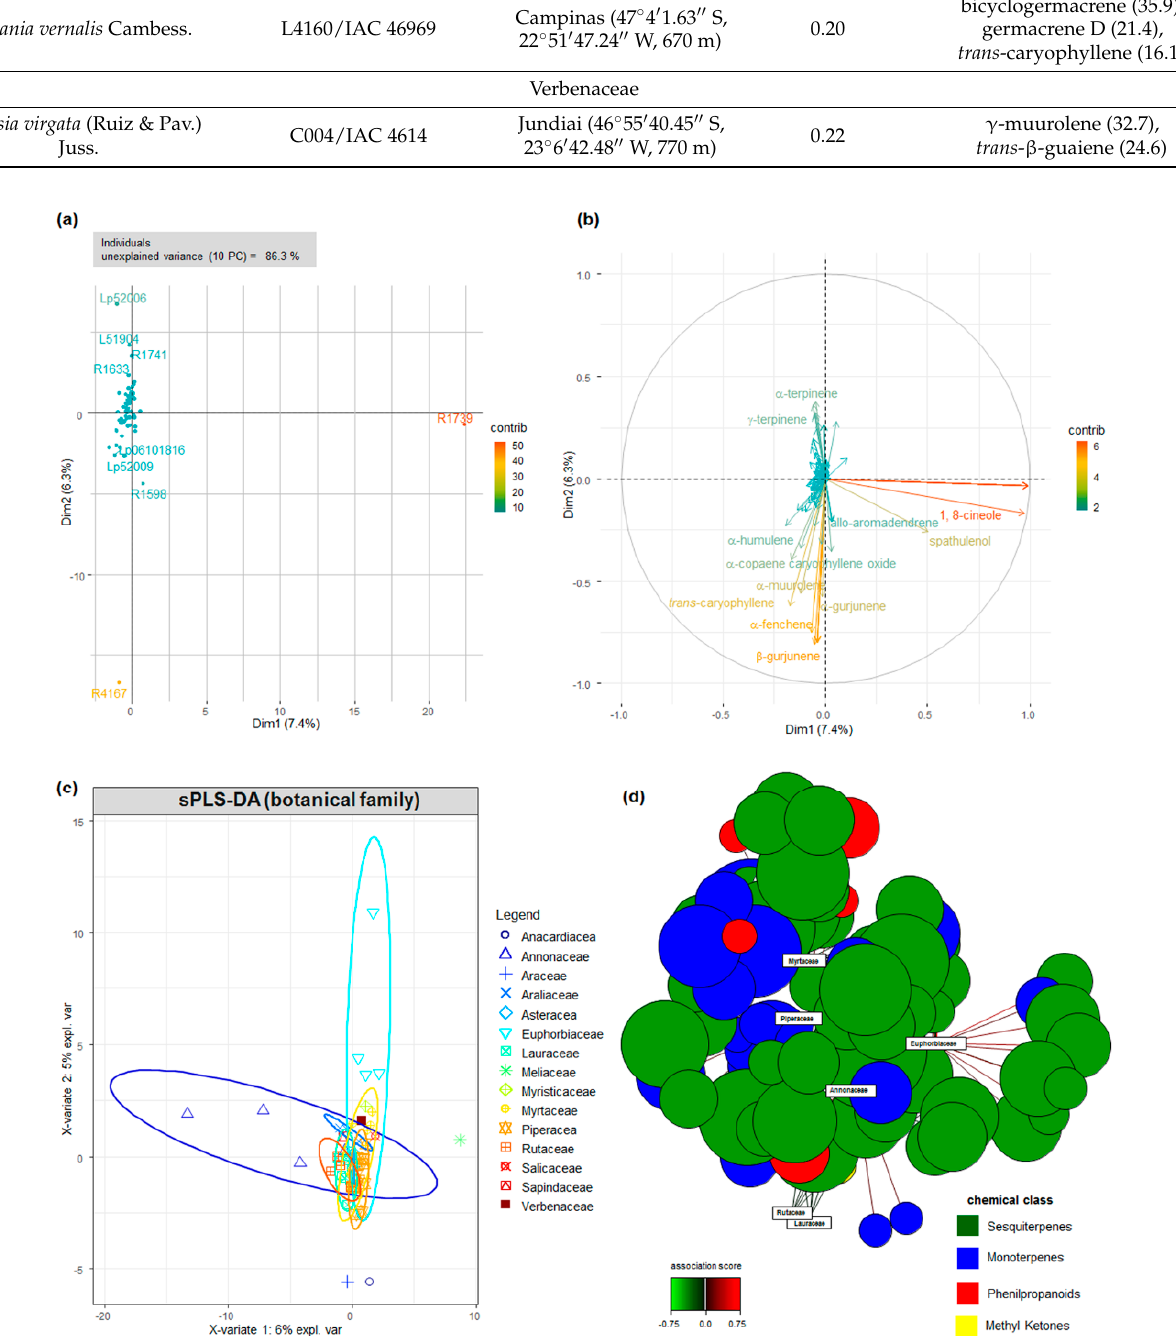
Figure 2. Multivariate analyses of the chemical composition of the Eos. Principal Component Analysis (PCA) of the chemical profile of the Eos, represented as ( a ) individual (EO sample) and ( b )